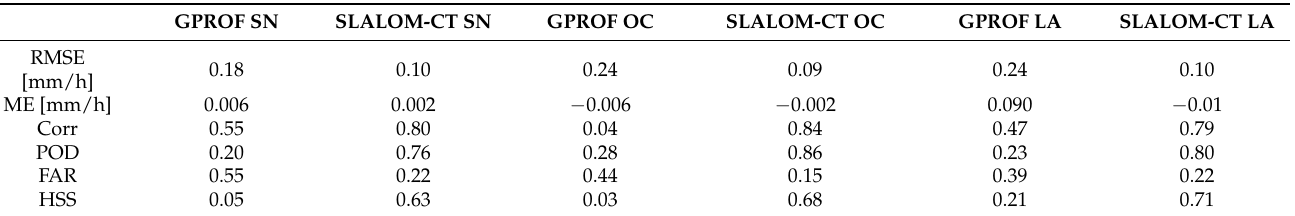
Table 9. Snowfall rate detection and estimation statistics. SN refers to snow-covered surfaces, LA to snow-free land, and OC to ocean and sea